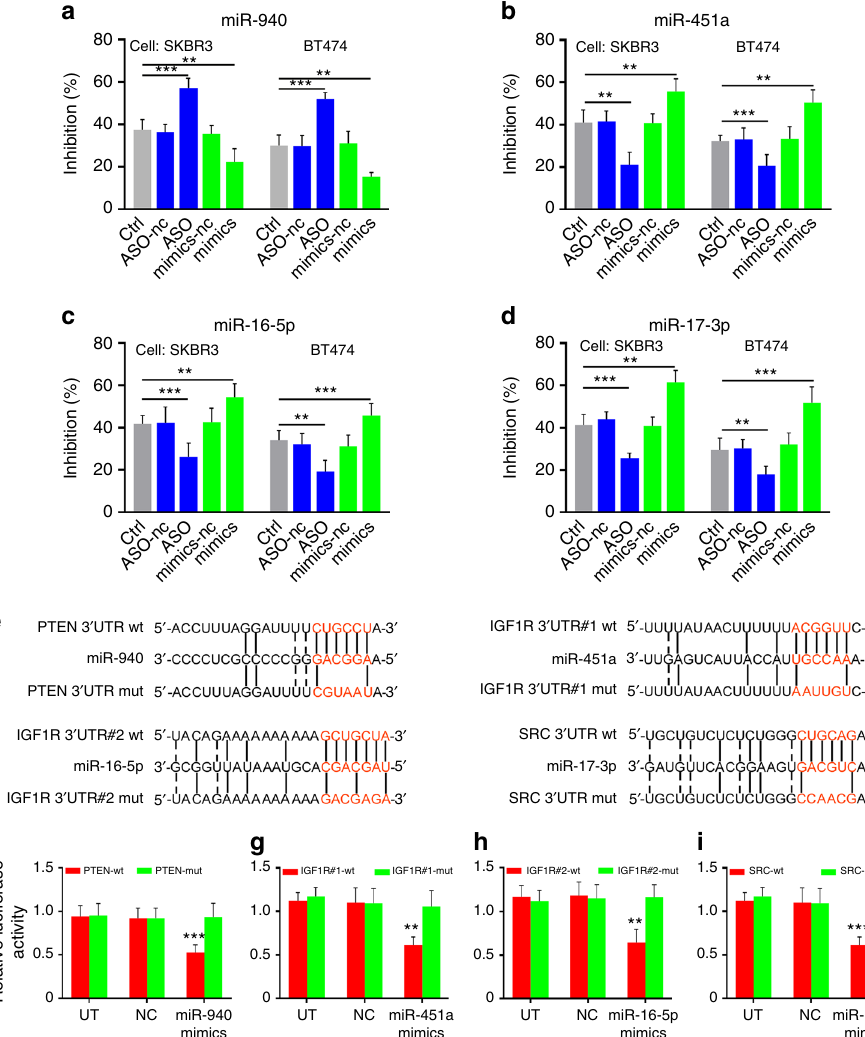
Fig. 7 Mechanism of the biomarkers for trastuzumab treatment resistance. a – d SKBR3 and BT474 were transduced with nc, ASO, or mimics of four miRNAs, then trastuzumab was added to the medium at 10 μ g ml − 1 for 3 days, MTS assay was used to compare cell proliferation/apoptosis of treated cells (mean + s.e.m., n = 5 independent experiments; ** P < 0.01; *** P < 0.001. P -values were obtained using two-tailed Student ’ s t -test). e TargetScan and MicroTar predicted PTEN as the target gene of miR-940, IGF1R as the target gene of miR-16-5p and miR-451a, and SRC as the target gene of miR-17-3p. Target sequences and their mutant forms of PTEN, IGF1R, and SRC in 3 ′ UTR were synthesized and subcloned into pGL3 promoter vector. f – i Luciferase reporter assays for SKBR3 cells transfected with pGL3 promoter vectors carrying PTEN-3 ′ UTR vs PTEN-mut-3 ′ UTR, IGF1R-3 ′ UTR vs IGF1R-mut-3 ′ UTR or SRC-3 ′ UTR vs SRC-mut-3 ′ UTR in the absence or presence of the indicated miRNA mimics. (mean + s.e.m., n = 5 independent experiments; ** P < 0.01; *** P < 0.001 compare to untreated cells by two-tailed Student ’ s t